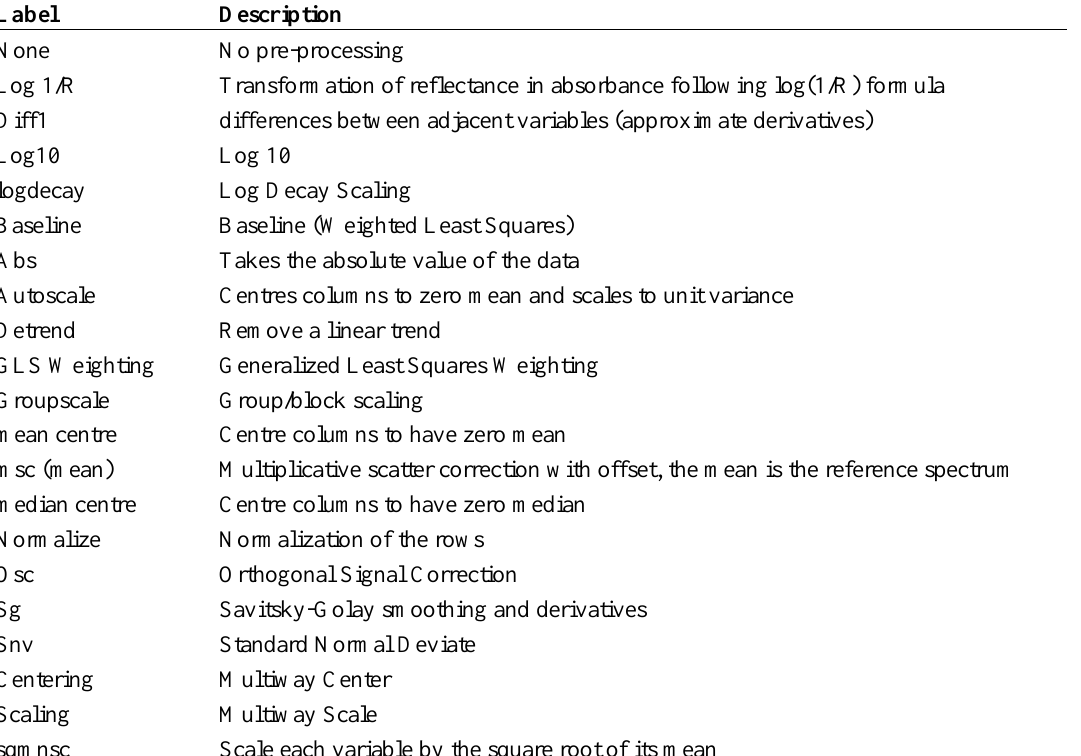
Table 1. List of the different X and Y pre-processing techniques applied in the